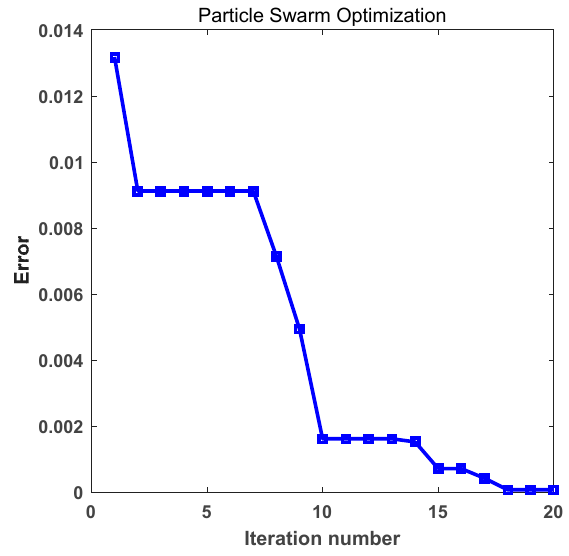
Figure 4. Calculation error of particle swarm optimization.